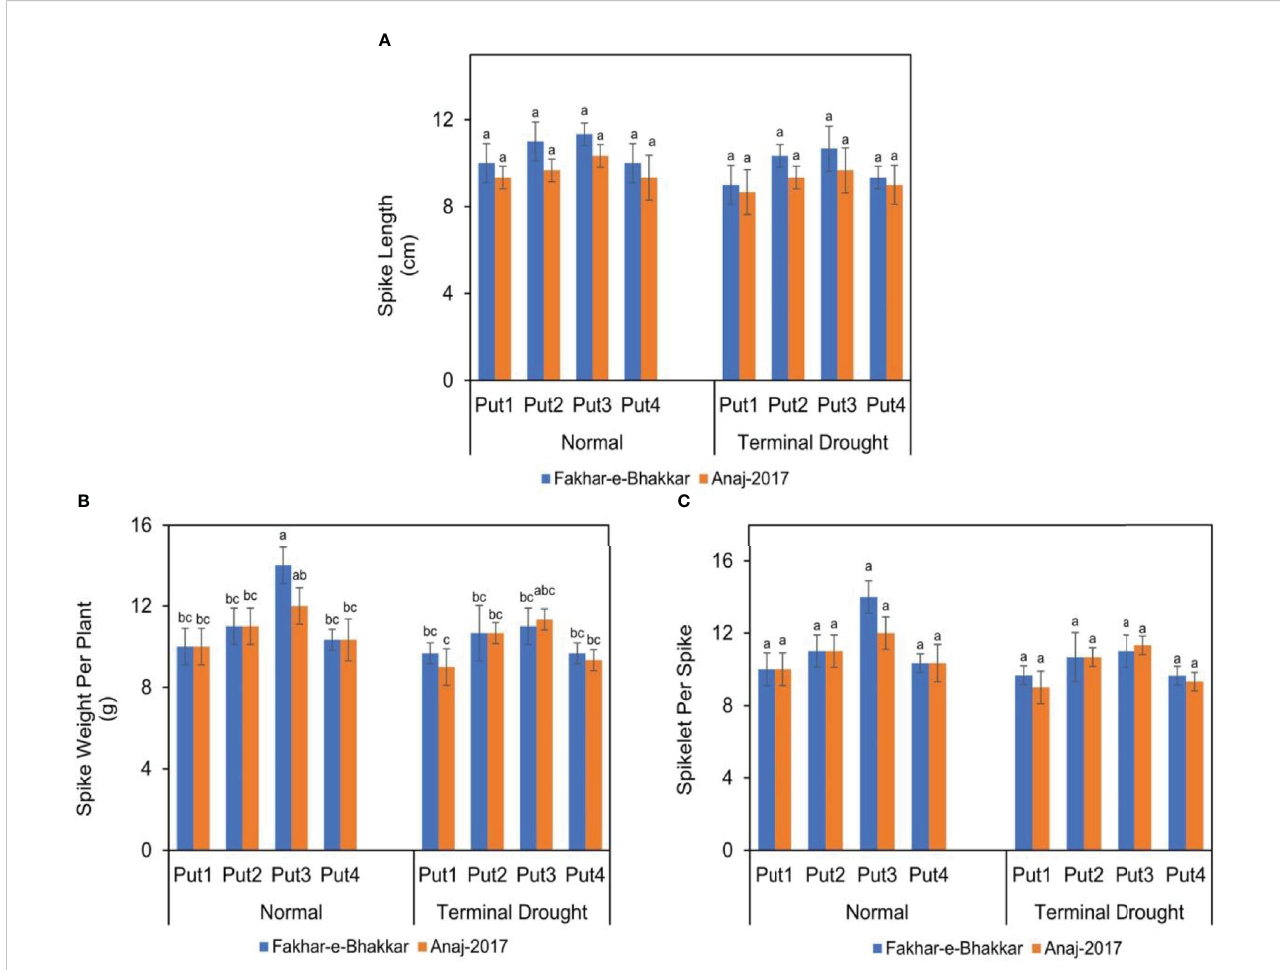
FIGURE 3 The effect of putrescine on the spike length (A) , spike weight (B) , and spikelets per spike (C) of two wheat cultivars under normal and terminal drought conditions. Abbreviation: PPM, parts per million, Put1, putrescine 0 PPM (untreated control); Put2, putrescine 0.5 PPM; Put3, putrescine 1.0 PPM; Put4, putrescine 1.5 PPM. The different letters above the bar columns indicate signi fi cant differences in mean ± SE at p< 0.05. At least three independent biological replications were considered for each